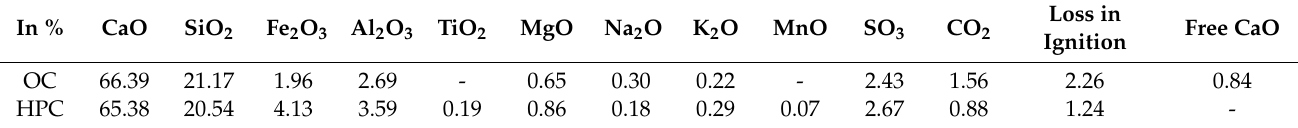
Table 2. The composition of the cement in OC and